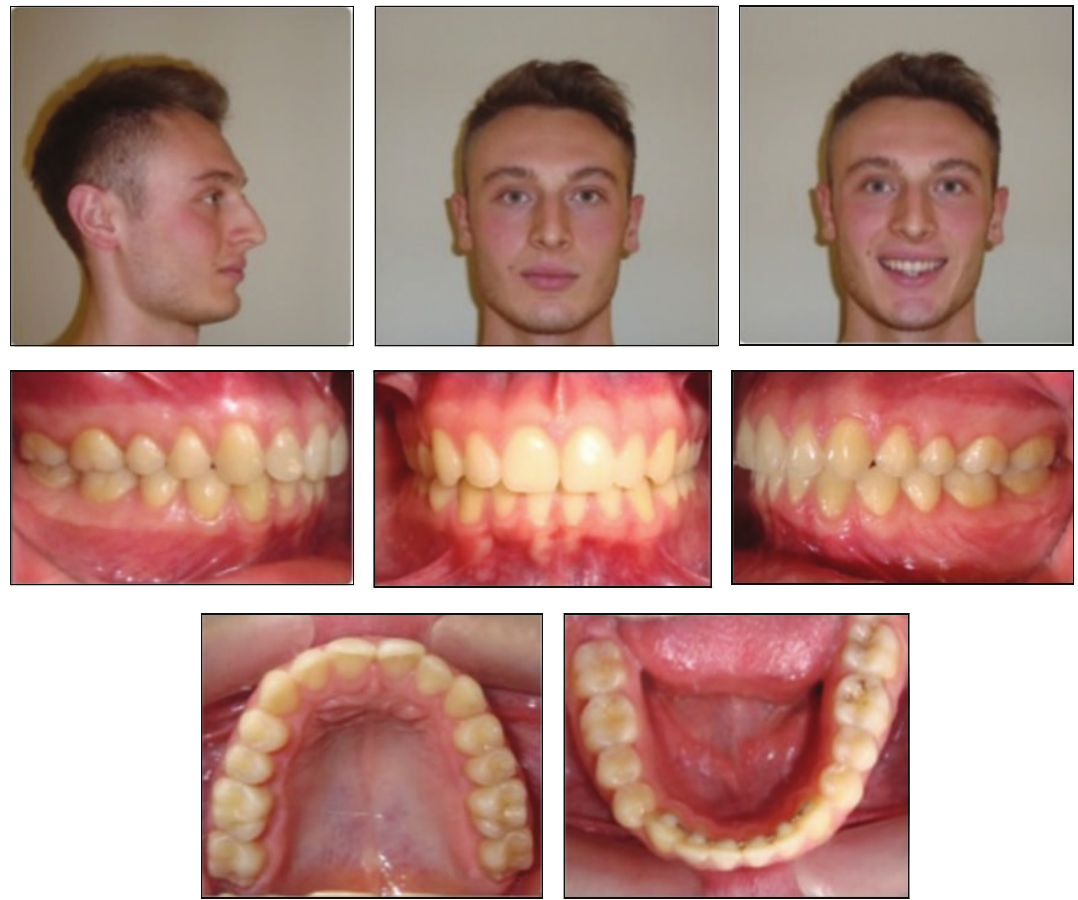
Figure 7: Facial and intraoral photographs after 5 years of